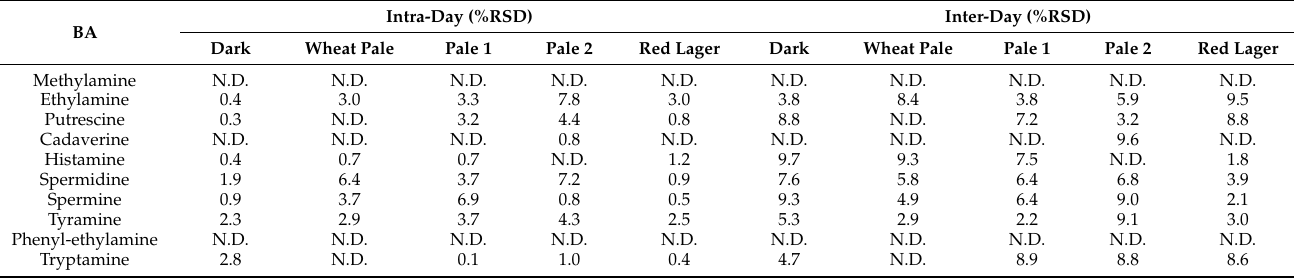
Table 3. Intra-day and inter-day precision of the proposed method is expressed in relative standard deviation (%RSD) by the analysis of craft beer samples ( n =